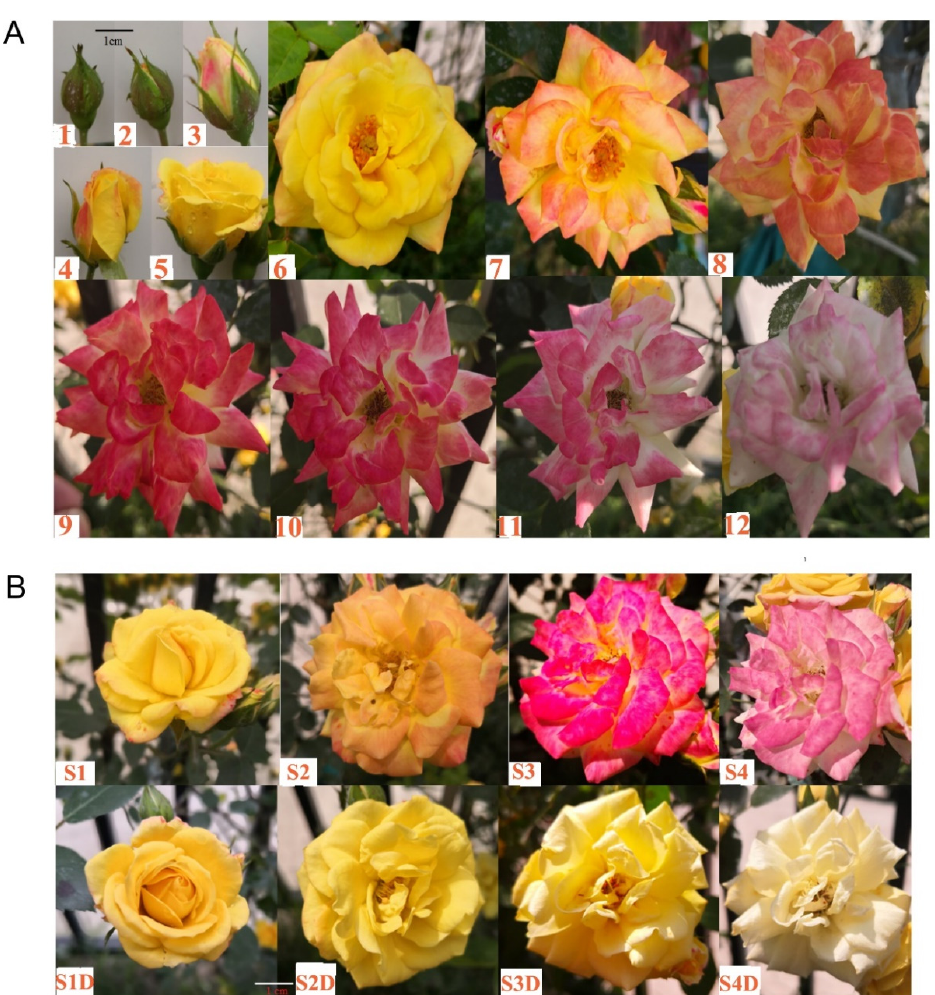
Figure 1. Changes in flower colors of the variety of ‘Chen Xi’ rose. ( A ) The different developmental stages of ‘Chen Xi’ rose flower from bud stage to flower blooming, and the flower color changed from yellow to red, and faded to white as it withers (1–12 represent the order of the development stages of ‘Chen Xi’ flower). ( B ) ‘Chen Xi’ flowers at four blooming stages under natural sunlight (S1–S4) and shading (S1D–S4D).